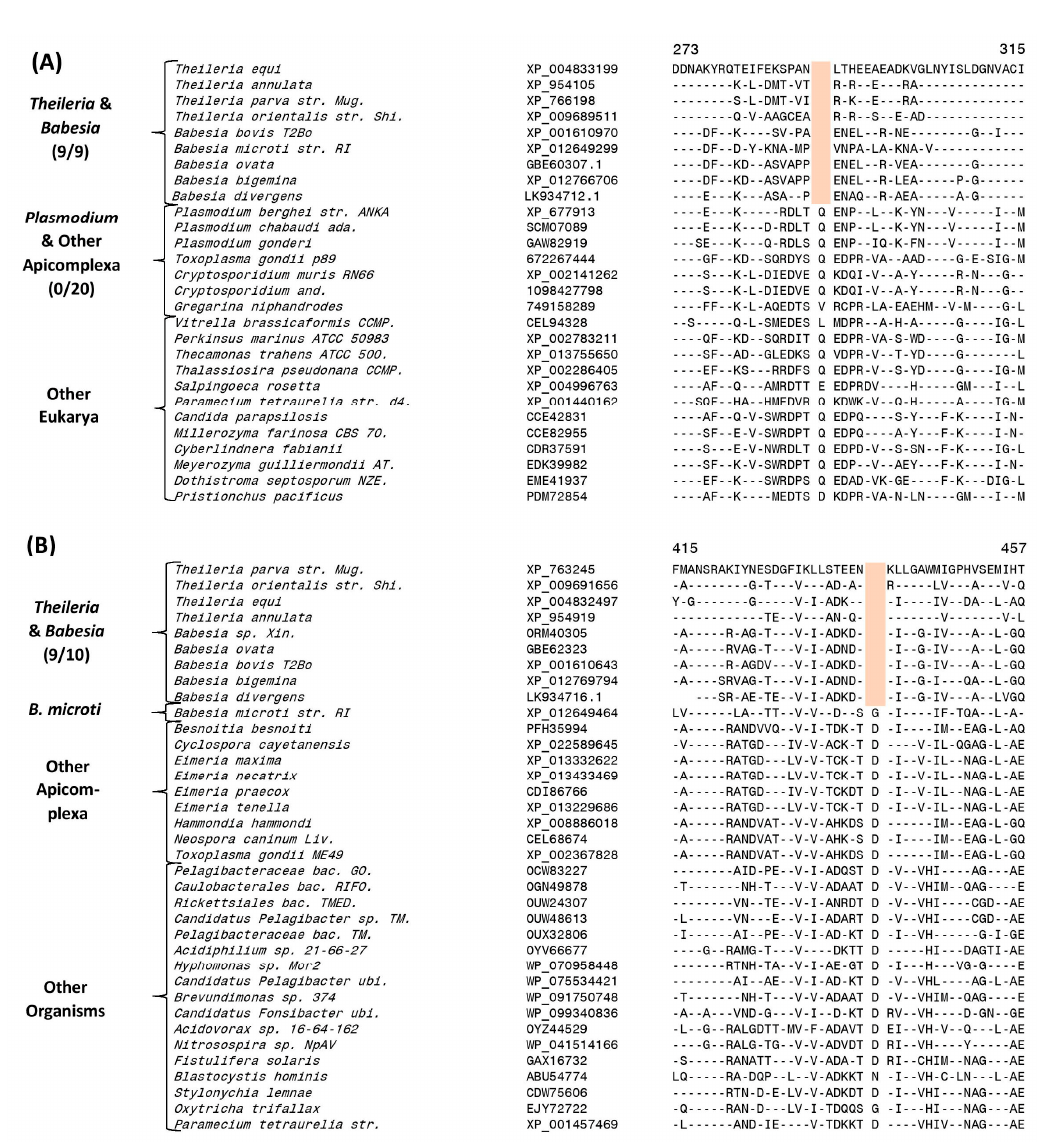
Figure 3. Sequence alignments showing conserved signature indels specific for members of the order Piroplasmida. ( A ) Partial sequence alignment of the protein succinyl-CoA synthetase β chain showing a 1-aa deletion that is uniquely shared by all available homologs from the order Piroplasmida. ( B ) Partial sequence alignment of the protein dihydrolipoamide dehydrogenase showing a 1-aa deletion in a conserved region that is present in all Piroplasmida homologs except Babesia microti . Sequence alignments for multiple other CSIs exhibiting similar specificities is